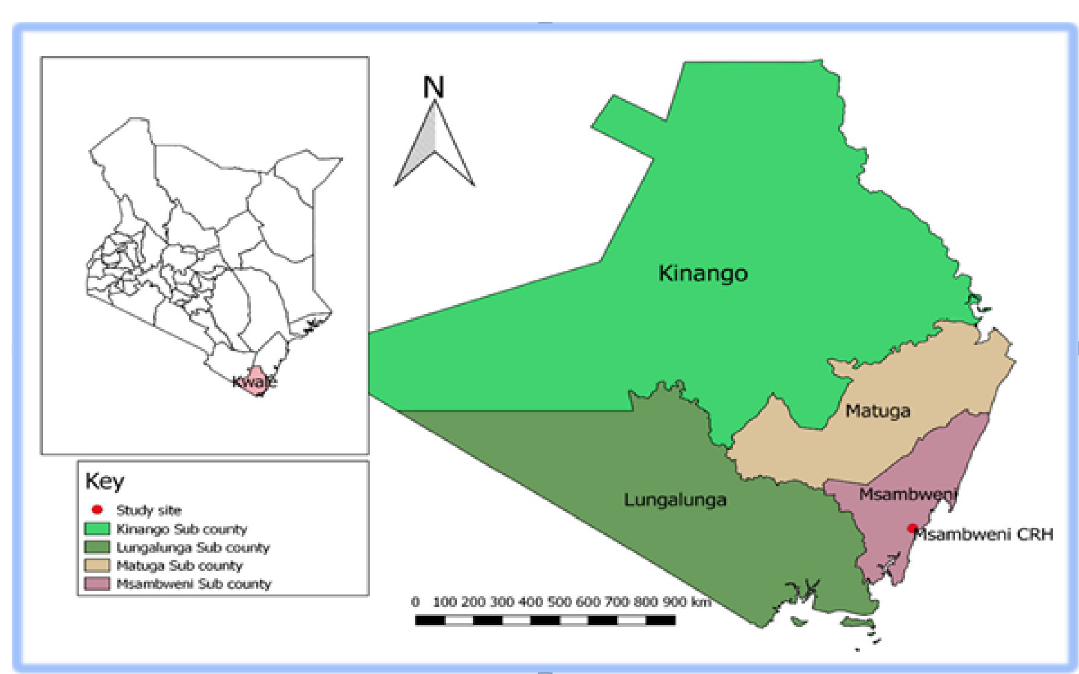
Fig 1. Map showing the study site—Kenyan map. Counties sampled (Map developed by Author using QGIS Version 2.18.10) with geographical data was obtained from https://africaopendata.org/dataset/kenya-counties-shapefile and data on geo—coordinates and category of health facility (Msambweni County Referral Hospital) was obtained from Kenya Master Health facility list http://kmhfl. health.go.ke/.